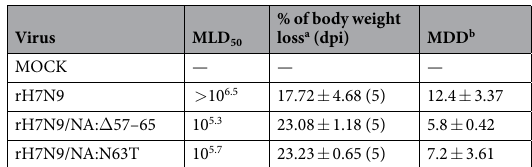
Table 4. Pathological findings from the mice infected with the rH7N9 and its NA stalk mutant viruses. a The mean maximum body weight losses and b MDD were obtained from the mice infected with 10 6 PFU. Each result was expressed in average with ±